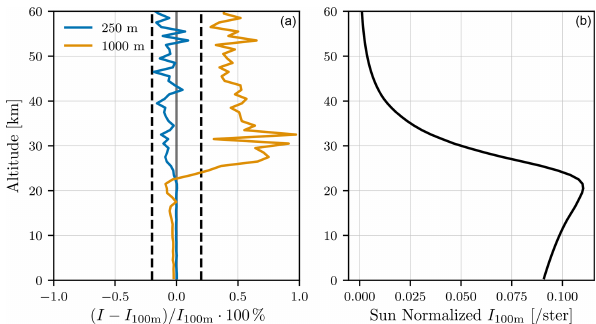
Figure 2. (a) Percent difference in single-scattered radiance at 351nm when MYSTIC is using 1000m or 250m homogeneous shells compared to 100m homogeneous shells. (b) The sun- normalized radiance computed using 100m shells. The atmosphere contains Rayleigh scattering, ozone absorption, and stratospheric aerosol Mie scattering with a SZA of 70 ◦ and a SAA of 30 ◦ . Re- fraction is disabled. MYSTIC was configured to use 100 million photons. Dashed vertical lines indicate ± 0 . 2%